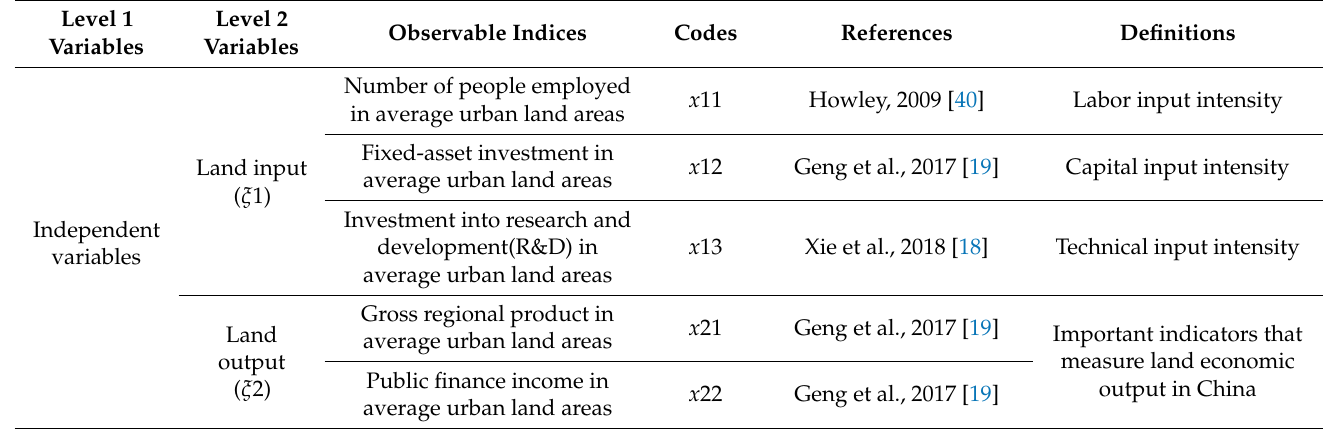
Table 1. Observable indices used to measure the independent and dependent